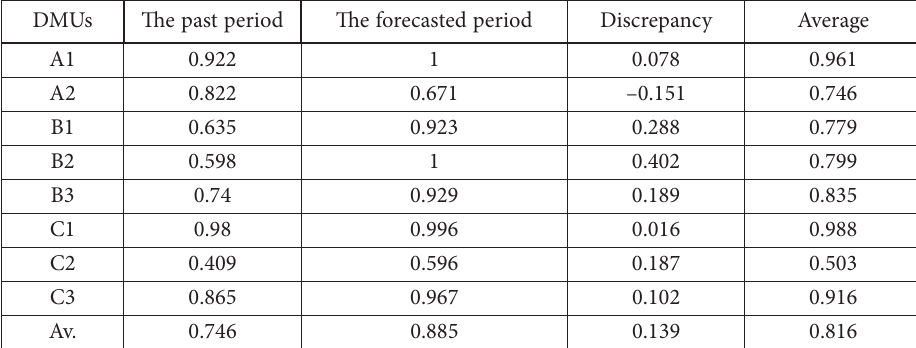
Table 6. Comparisons between the past and future period (source: compiled by the author)